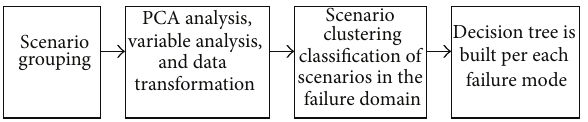
Figure 1: Grouping and classification